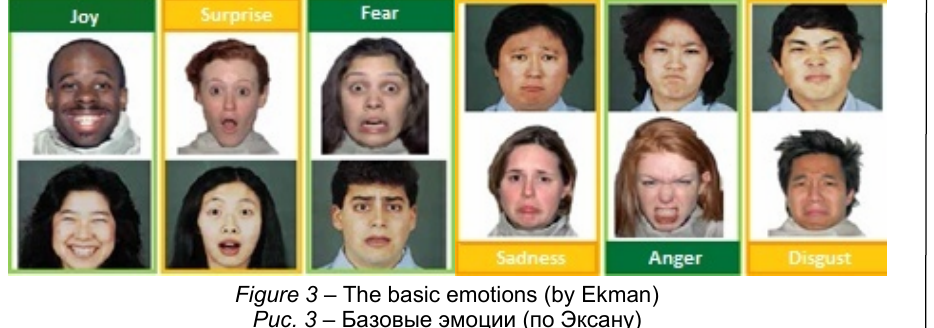
Figure 3 – The basic emotions (by Ekman) Рис . 3 – Базовые эмоции ( по Эксану